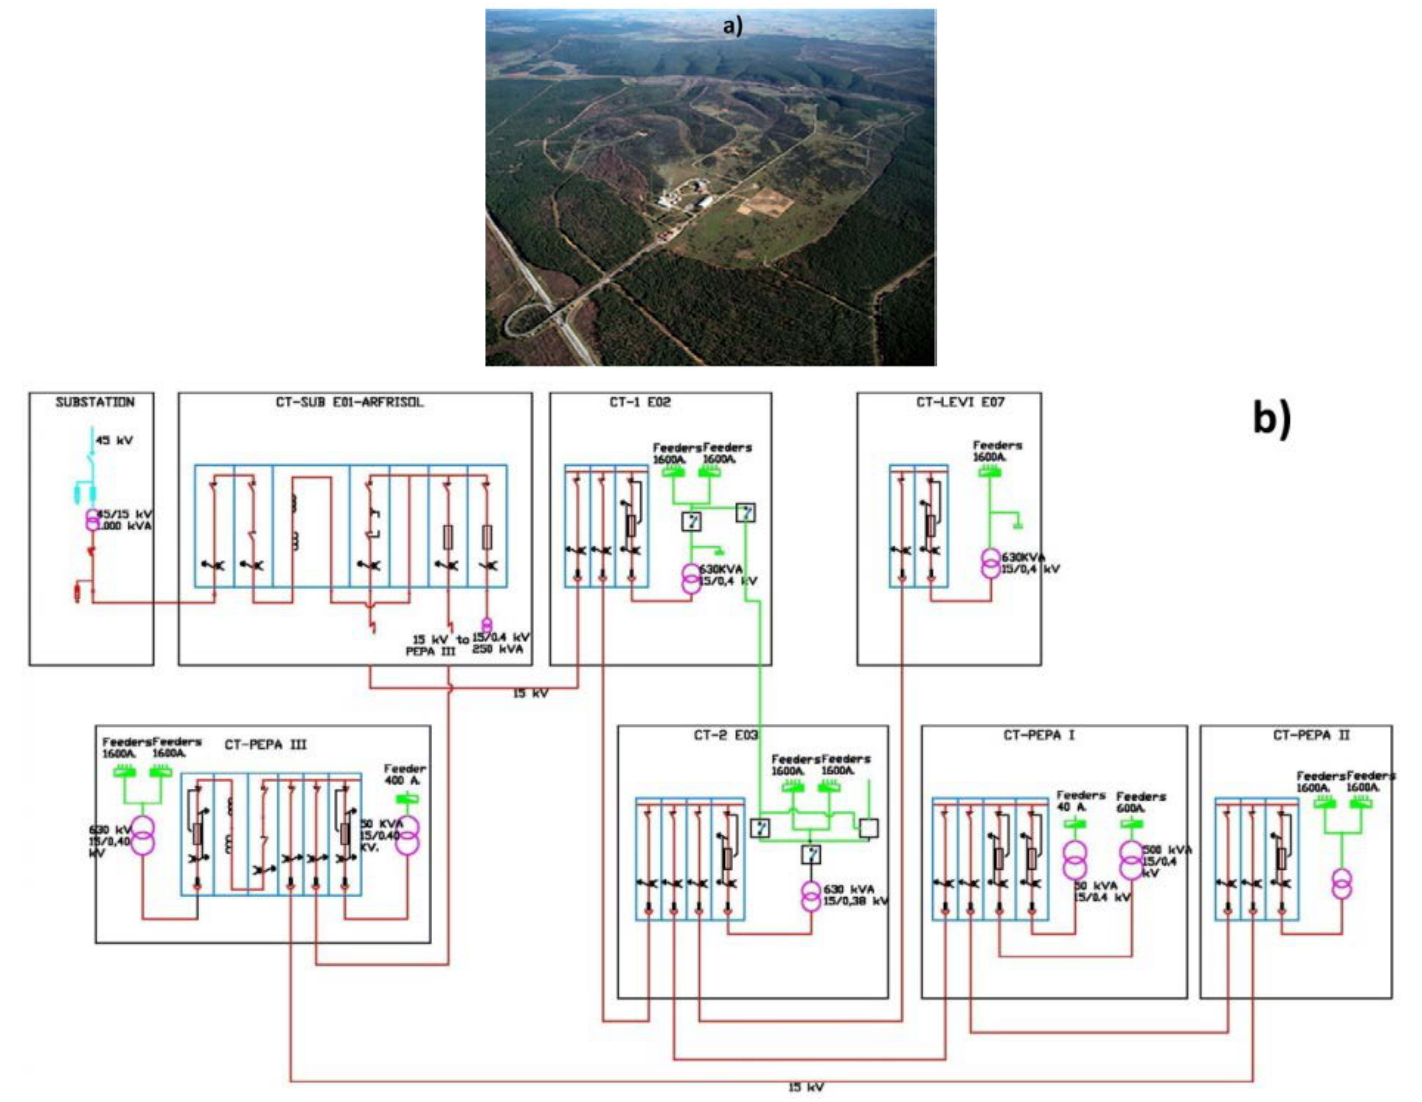
Figure 2. ( a ) Aerial photography of CEDER-CIEMAT ; ( b ) Medium voltage electrical diagram of the microgrid